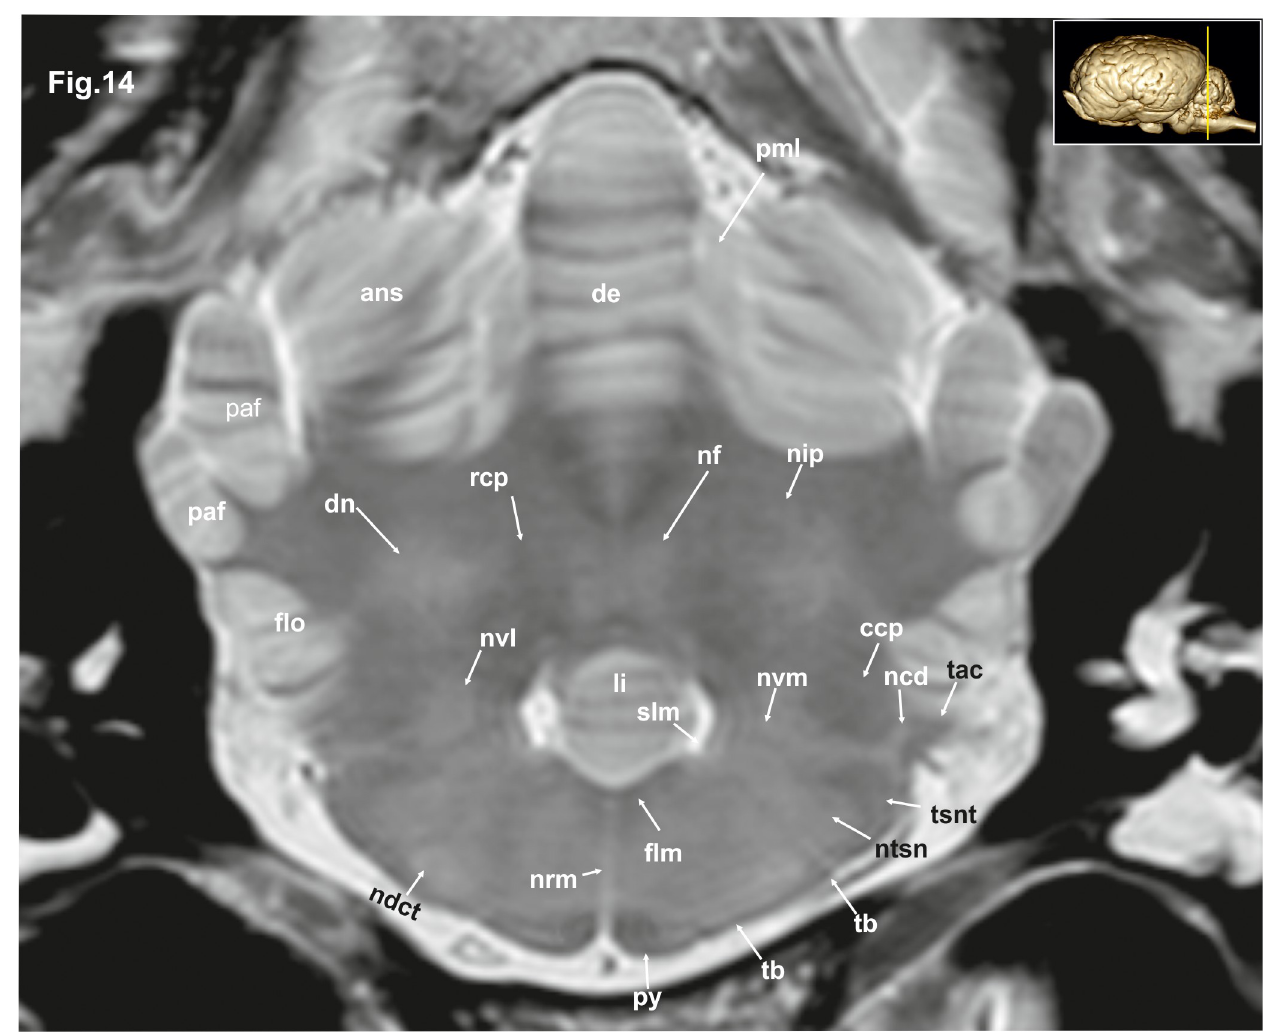
Fig 14. Transverse magnetic resonance image of the equine brain on the level of the acoustic tubercle. ans: ansiform lobule, ccp: caudal cerebellar peduncle, dctb: decussation of the fibres of trapezoid body, de: declive of the vermis, dn: dentate nucleus, flm: medial longitudinal fasciculus, flo: flocculus, li: lingula of the vermis, ncd: dorsal cochlear nucleus, ndct: superior olivary nucleus, nf: fastigial nucleus, nip: interpositus nucleus, ntsn: nucleus of the spinal tract of the trigeminal nerve, nvl: lateral vestibular nuclei, nvm: medial vestibular nucleus, paf: paraflocculus, pml: paramedian lobule, py: pyramis of the vermis, rcp: rostral cerebellar peduncle, slm: sulcus limitans, tac: acoustic tubercle, tb: trapezoid body, tsnt: spinal tract of the trigeminal nerve. S1 Fig: Ectg) sulcus. Immediately rostral to the lamina terminalis beneath the rostrum of the corpus callosum is a cortical part called the subcallosal gyrus. In the caudal aspect of the hemi- sphere endosplenial (Sulcus endosplenialis; Fig 26: Enspl) and suprasplenial sulcus (Sulcus suprasplenialis; Figs 1E, 9, 12 and 24–26: Sspl) flank the splenial sulcus. Subpallial grey matter. The basal ganglia comprise a distributed set of brain structures in the telencephalon and diencephalon. The substantia nigra (Figs 8, 9, 10, 19 and 28–31; S7 and S8 Figs: snr) of the midbrain as well as the subthalamic nucleus (Fig 29: stn), which is located in the caudal diencephalon are both functionally connected to this system. The largest group of these nuclei is the large striate body (Corpus striatum), which is subdivided into two parts (caudate nucleus, lentiform nucleus) by fiber masses of the internal capsule (Figs 4–7, 19, 21, 22, 23, 30 and 32–34; S2–S6 Figs: ic). The caudate nucleus (Figs 3–8, 21–23, 27, 28 and 29–31;